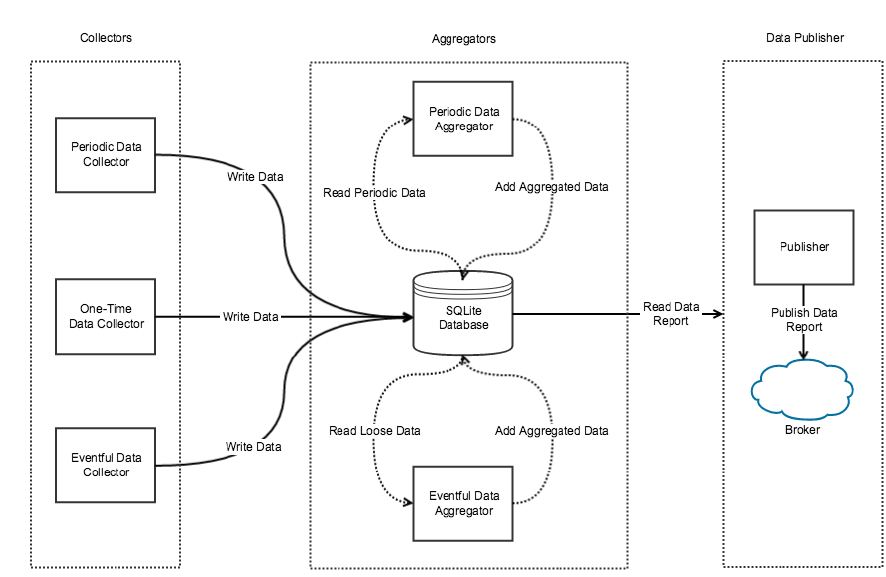
Figure 3. Components of the device agent.